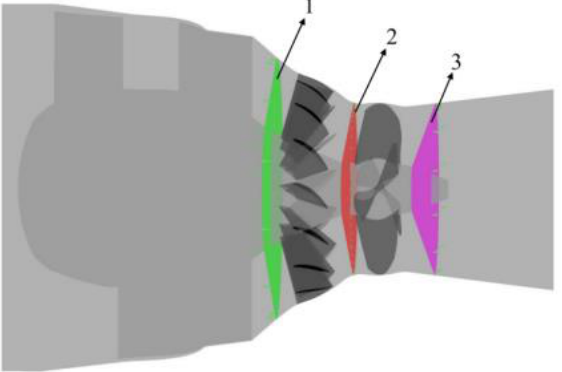
Figure 6. Interface between overcurrent components.